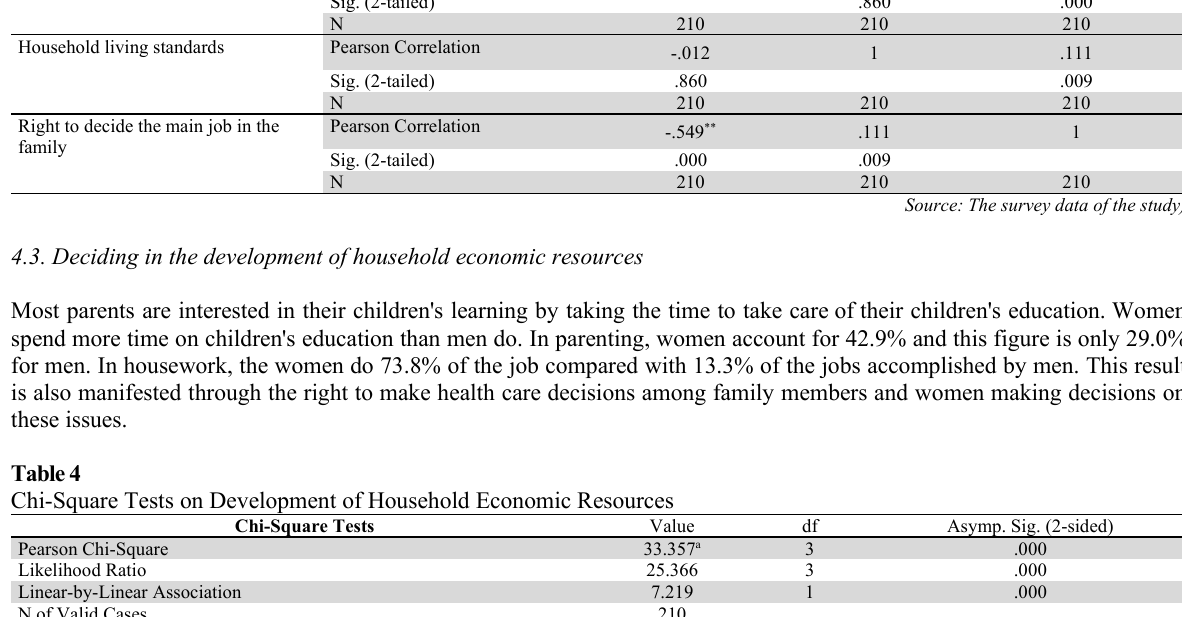
Results of Cronbach’s Alpha Testing of Attributes